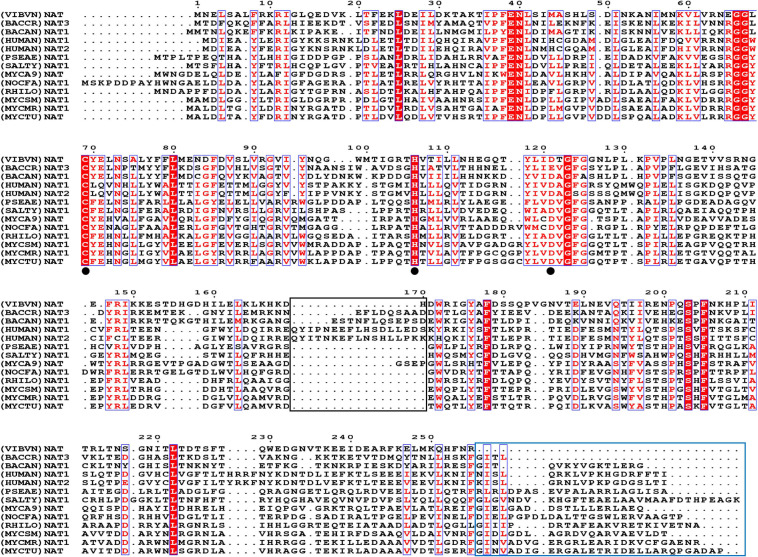
The amino acid sequence alignment results. Comparison of (VIBVN)NAT with 10 bacterial NAT proteins and two human NAT proteins, Bacillus cereus (BACCR), Bacillus anthracis (BACAN), Homo sapiens (HUMAN), Pseudomonas aeruginosa (PSEAE), Salmonella typhimurium (SALTY), Rhizobium loti (RHILO), Mycobacterium smegmatis (MYCSM), Mycobacterium abscessus (MYCA9), Nocardia farcinica (NOCFA), Mycobacterium marinum (MYCMR), and Mycobacterium tuberculosis (MYCTU). Fully conserved residues are highlighted in a red background, and semi conserved residues are highlighted in red font. The black frame indicates the “mammalian/eukaryotic insertion loop.” The blue frame indicates the lack of the C-terminal region. The catalytic triad is indicated by a black dot.